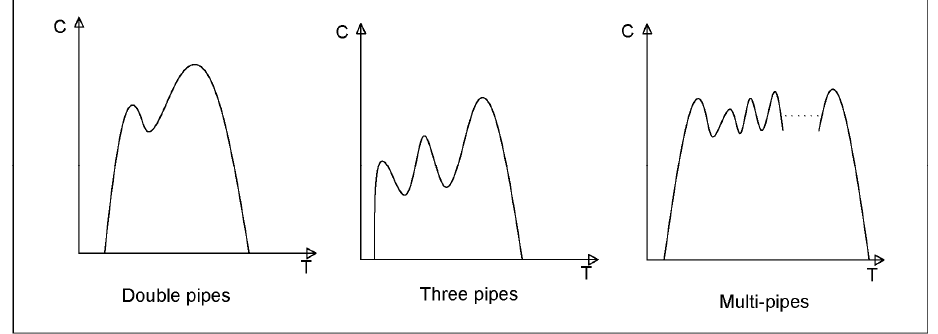
Figure 3. Concentration ‐ Time curve of pipeline ‐ fracture water inrush